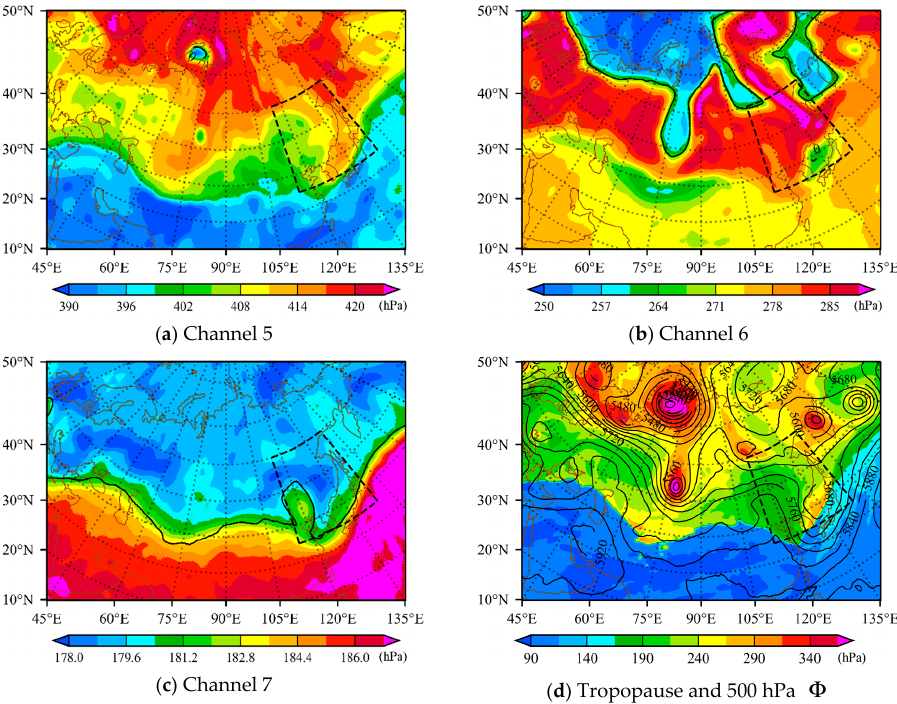
Figure 4. Spatial distributions of ( a – c ) peak WF altitudes of MWTS-2 channels 5–7 and ( d ) tropopause pressures at 06:00 UTC 23 June 2019 (color shaded, unit: hPa) with ERA5 500 hPa geopotential height (contours, interval: 40 gpm). The black solid curves indicate where the differences between peak WF altitude and tropopause pressure are zero, and peak WF altitudes are smaller on the north side of the curve. All WFs are calculated by RTTOV with ERA5 reanalysis as input, and tropopause pressure is calculated with temperature from ERA5 reanalysis. Lambert projection with standard latitudes of 30°N and 60°N is used here, and the black dashed box represents the NCCV domain (35–60°N, 115–145°E).